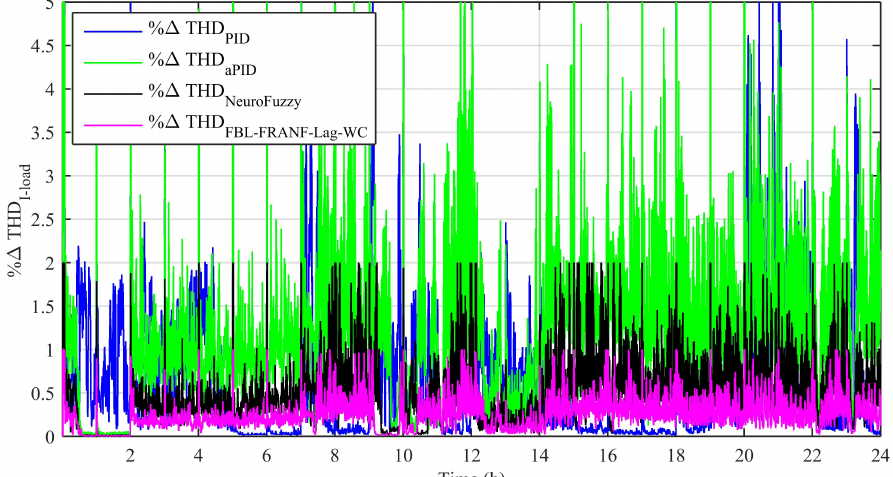
Figure 8. % ∆ THD in the load